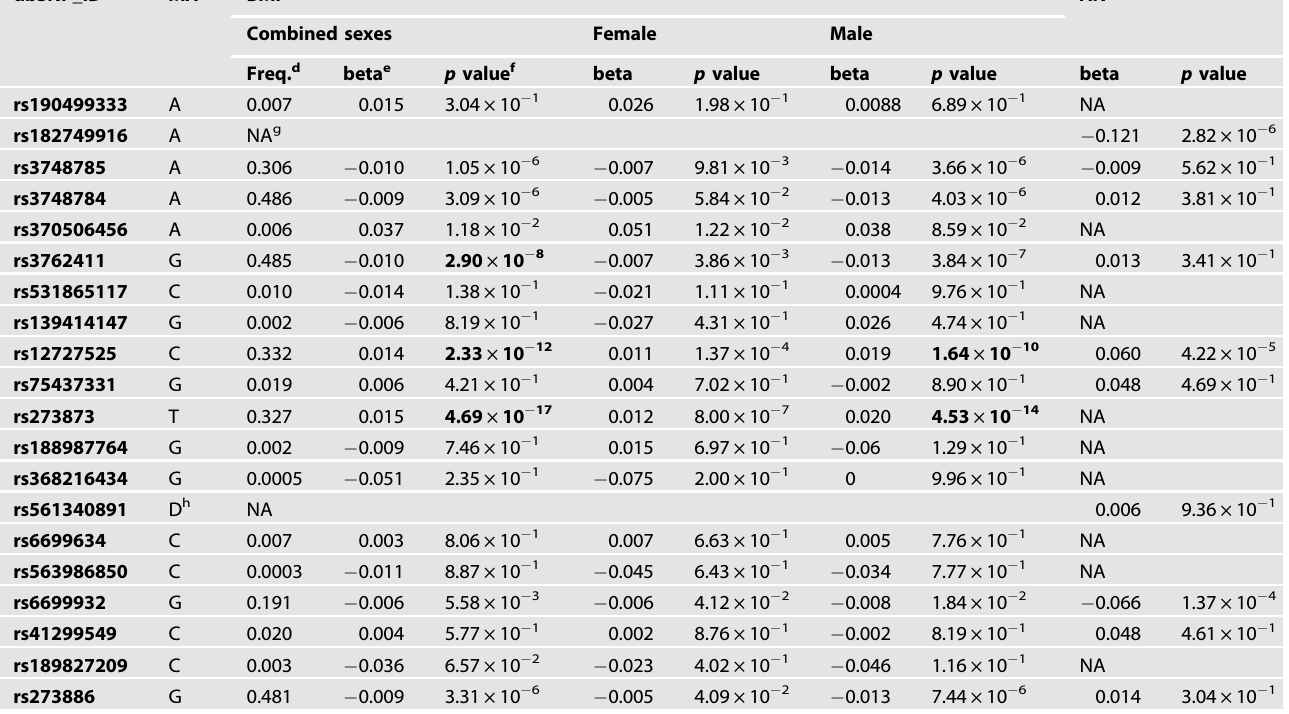
Table 2. Variants in PTBP2 looked up in GWAS datasets for BMI and